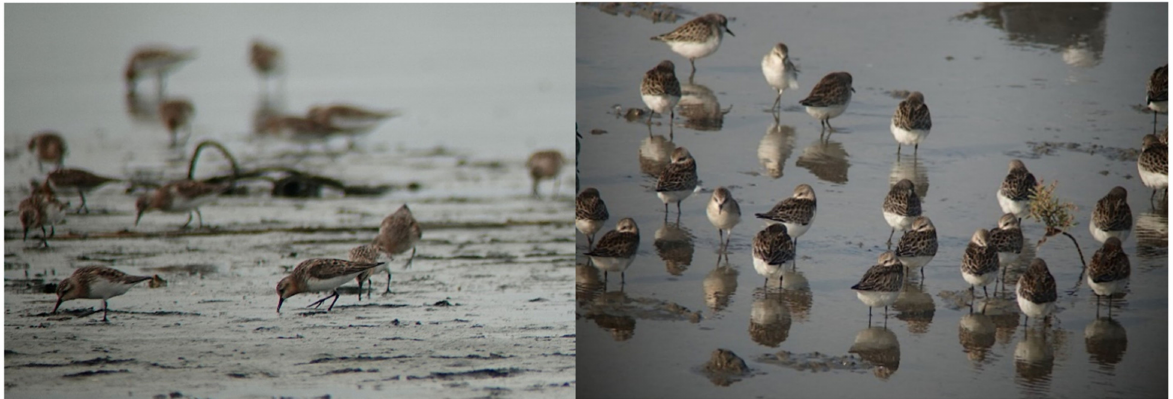
Figure 6. Different plumages of Calidris ruficollis in the Hwaseong Wetlands FNS. On left, adults in July in 2–1; on right, juveniles in September in